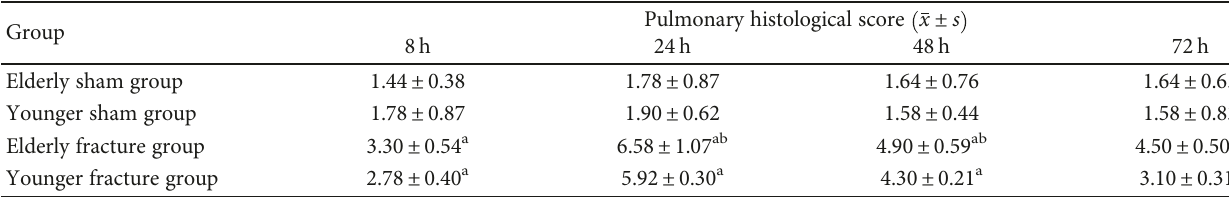
a P < 0 05 for the elderly fracture group versus the elderly sham group and the younger fracture group versus the younger sham group at the same time point. b P < 0 05 for the x elderly fracture group versus the younger fracture group at the same time